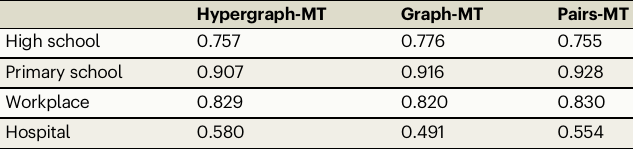
Table 2 | Comparison of community detection algorithms in human close-proximity contact interactions